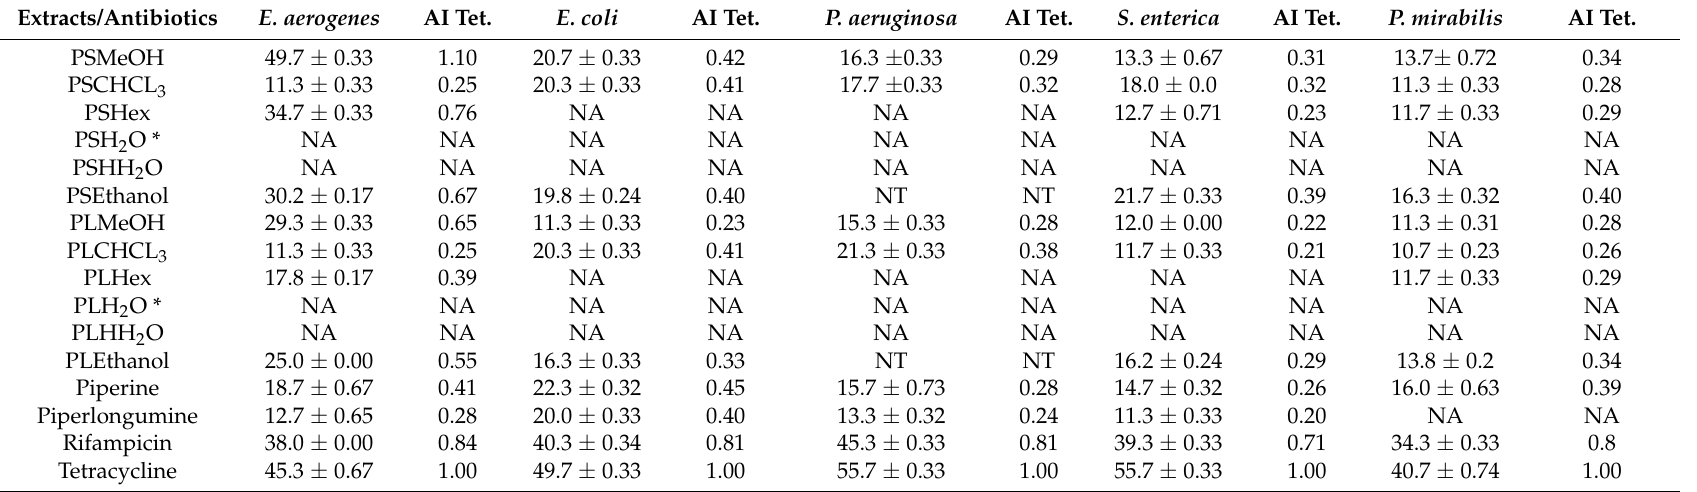
Table 1. Antibacterial effects of extracts of P. guineense , piperine and piperlongumine against Gram-negative bacteria. Results obtained with the agar diffusion method. Activity index (AI) describes the activity of the extracts and compounds in relation to tetracycline.